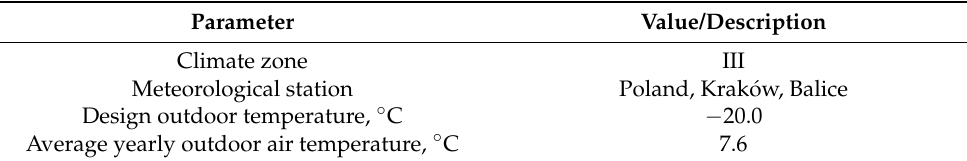
Table 2. Basic simulation data.